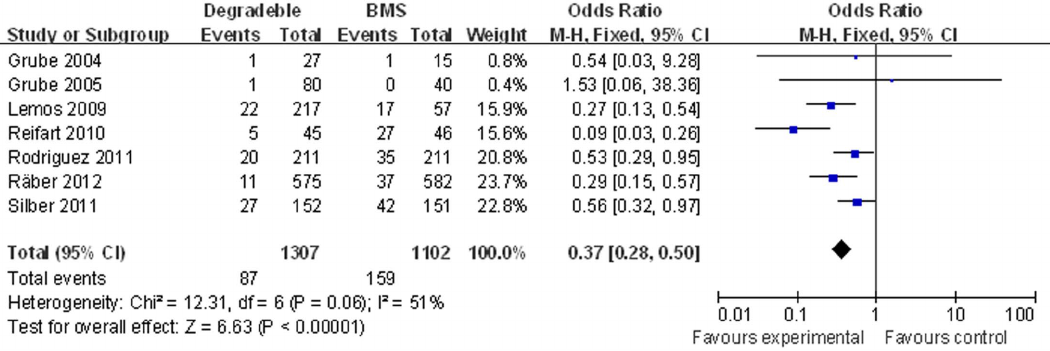
Figure 6. Individual and summary odds ratios for TVR in patients treated with BP-DES vs. BMS.